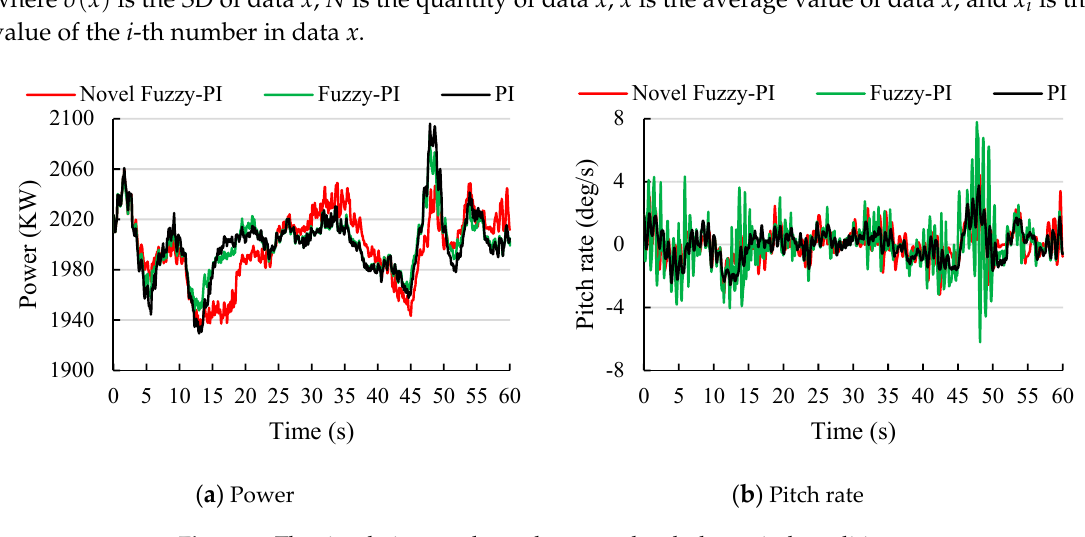
Figure 8. The simulation results under normal turbulent wind conditions. Table 4. Analysis of simulation results under normal turbulent wind